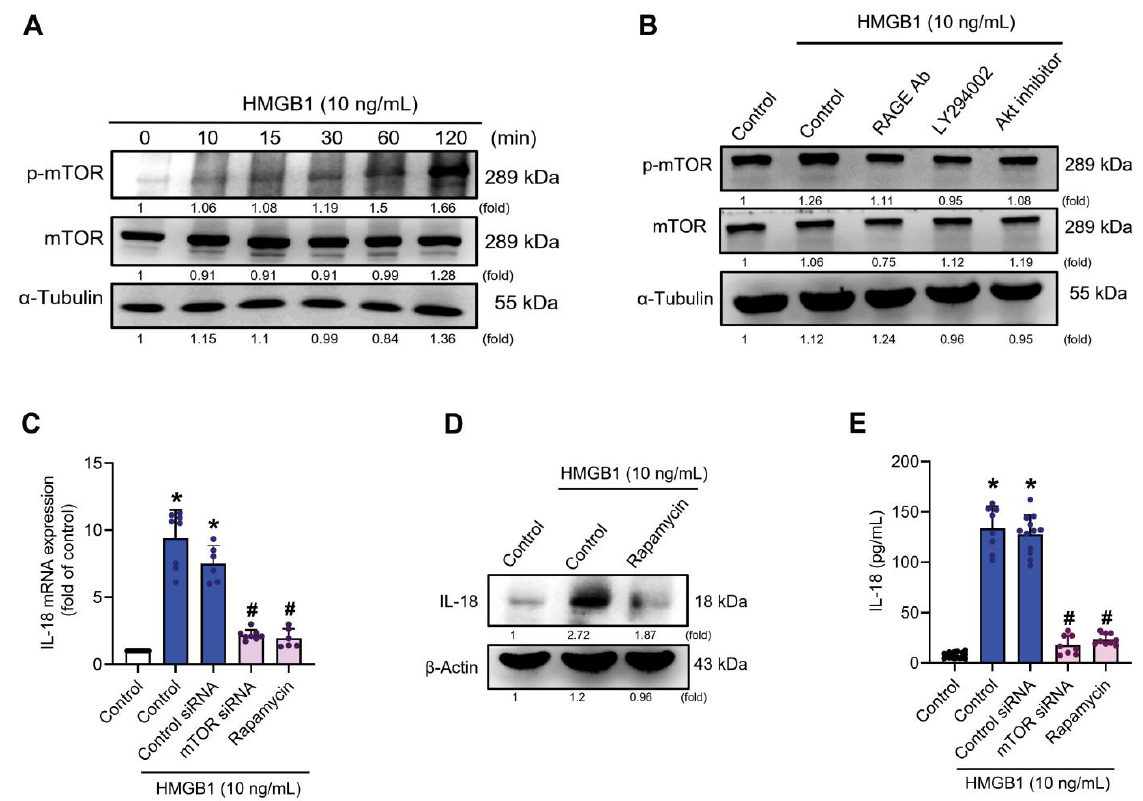
Figure 4. The mTOR signaling pathway is involved in HMGB1-induced upregulation of IL-18 expression. ( A ) C2C12 cells were treated with 10 ng/mL HMGB1, then cell lysate was collected at the indicated time points and subjected to immunoblotting to